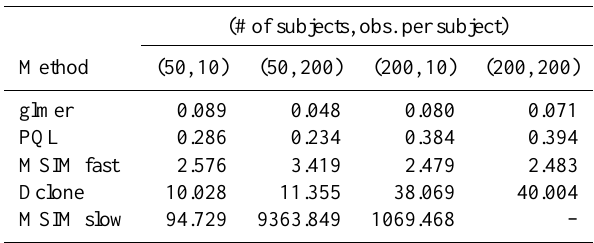
Table 5. Total system time (in seconds) results for Nokomis. (# of subjects, obs. per